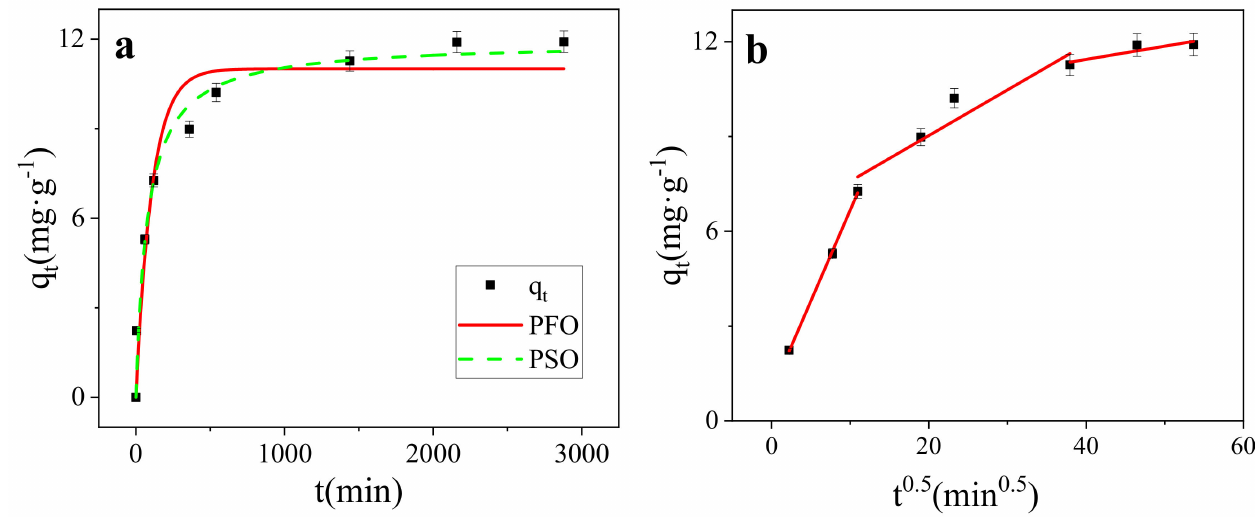
Figure 6. ( a ) Kinetics models of SMB (298 K); ( b ) Intraparticle diffusion model of SMB (298